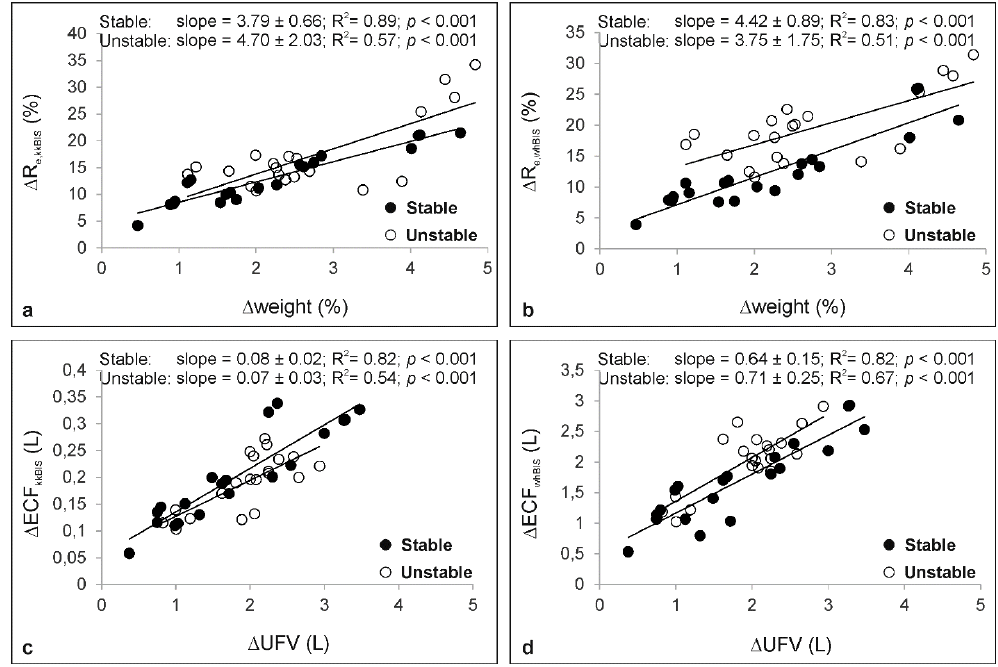
Fig.4: Pre-HD to post-HD comparison of (a-b) relative changes in R e,kkBIS (%) and R e,whBIS (%), respectively, with changes of patient weight (%). Pre- HD to post-HD comparison of (c-d) changes in ∆ECF kkBIS (L) or ∆ECF whBIS (L), respectively, with cumulative ultrafiltration volume (UFV, L). Each patient has two